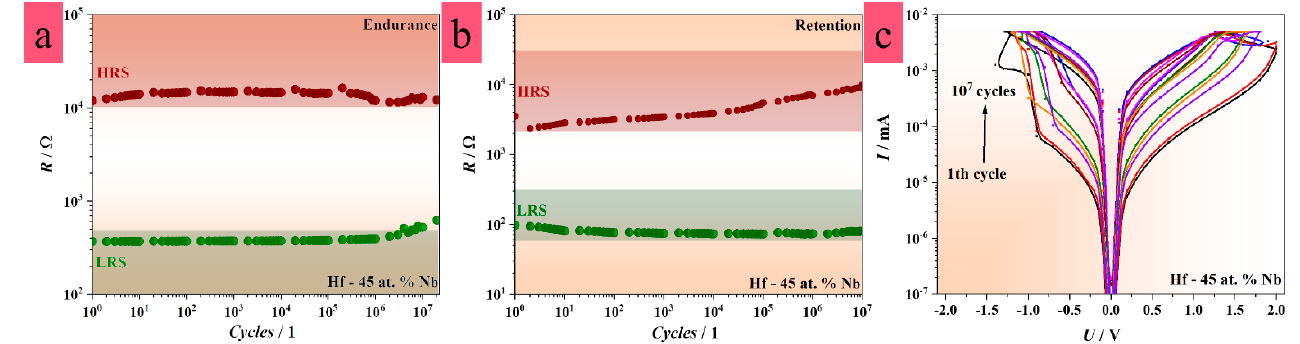
Figure 5. ( a , b ) Endurance and retention measurements recorded for MIM structures with improved memristive properties, ( c ) I-U sweeps recorded during consecutive writing procedure (endurance